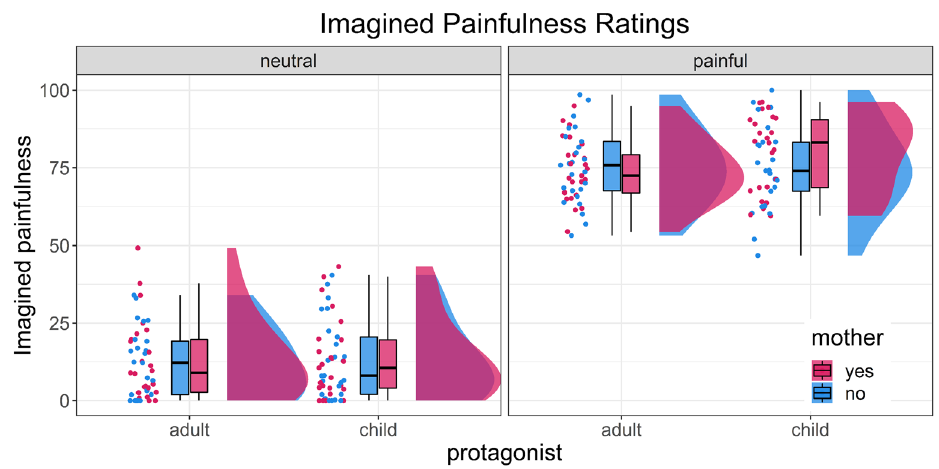
Figure 2. Imagined painfulness rated during the fMRI paradigm. The imagined painfulness of half of all stimuli was rated on a continuous scale from 0 to